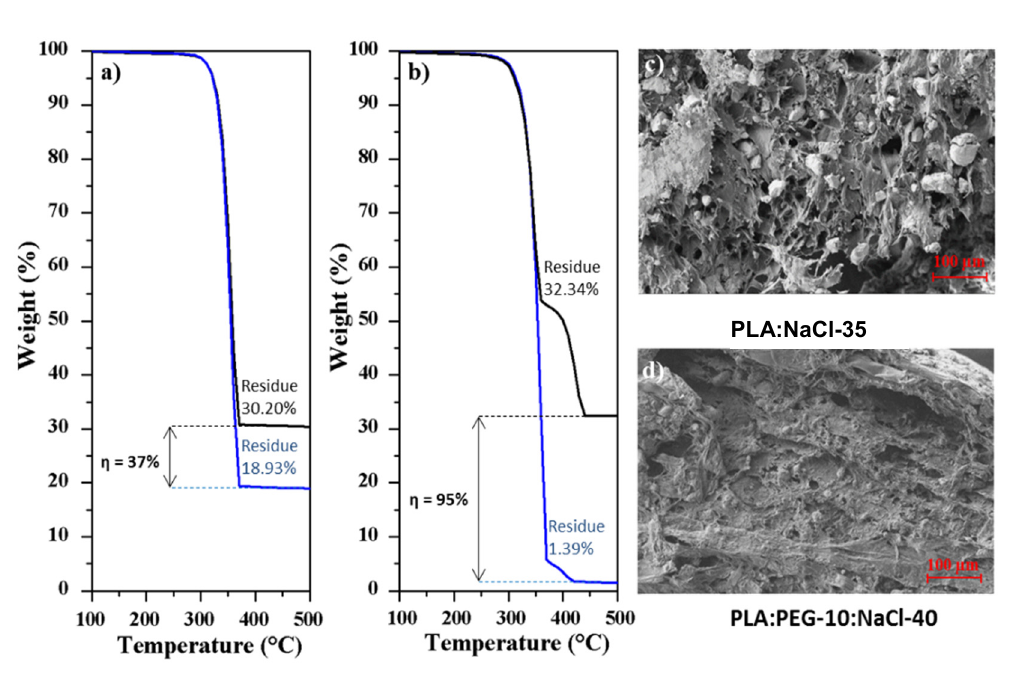
Figure 11. TGA profiles of PLA:NaCl-35 ( a ) and PLA:PEG-10:NaCl-40 ( b ) specimens as molded (black lines), and after being washed (blue lines). ( c , d ) SEM micrographs of cross sections of both samples after being washed.